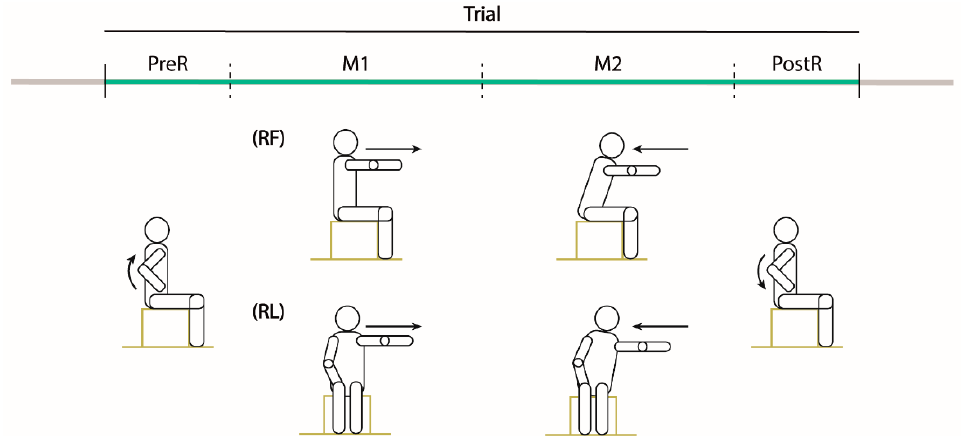
Figure 1. Experimental tasks. Drawings of one trial of the MFRT in the forward (RF) and lateral (RL) directions. Participants were seated on a stool without back support inside the acquisition volume defined by the motion capture system and were asked to maintain the feet on the stool support with shoulder width apart and the contralesional arm along the side with the hand on the thigh. Then, starting from the sitting posture with the trunk as straight as possible, they had to perform the reaching movement with their ipsilesional arm at their comfortable speed. Each trial was divided in four phases: PreR (raising the ipsilesional arm up), M1 (reaching movement to the maximum distance), M2 (reaching movement back to the initial position) and PostR (lowering the arm).